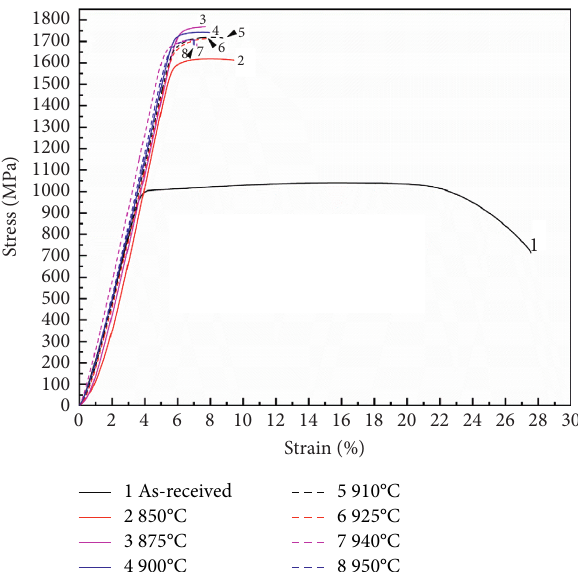
Figure 11: The stress-strain curve of as-received specimen and samples after rapid heat treatment followed by ageing. 170017101720173017401750176017701780